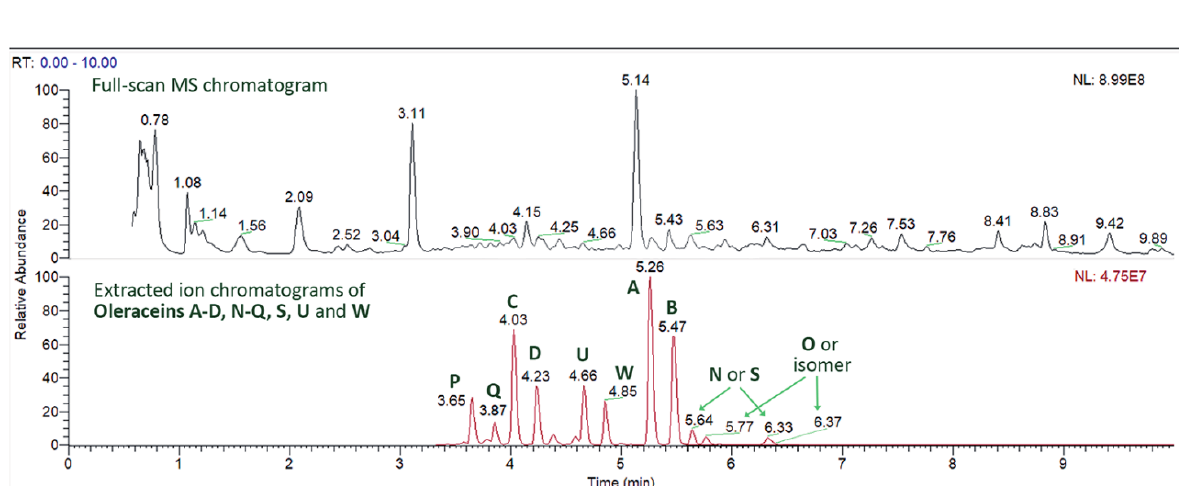
Fig. 5: Full-scan MS chromatogram and extracted ion chromatogram of tentatively identified Oleraceins by UHPLC-MS